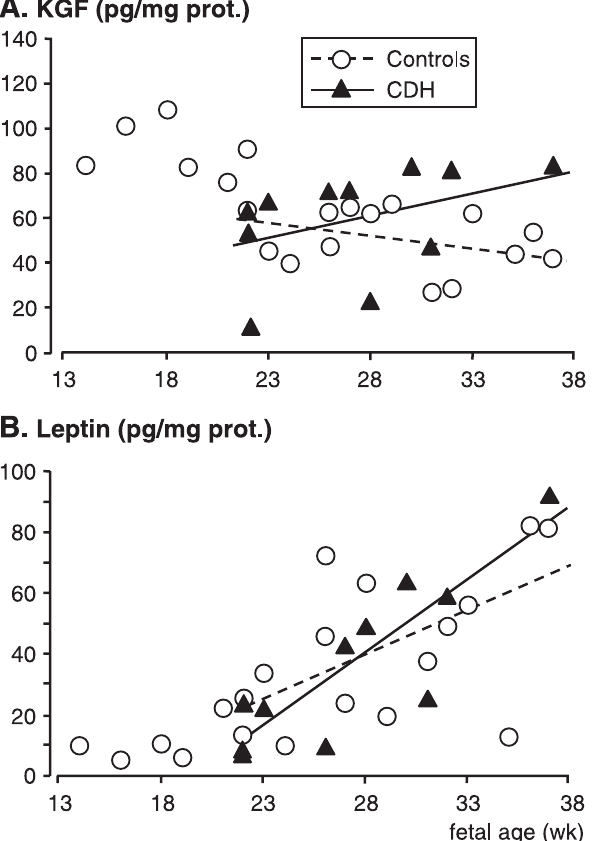
Figure 4. KGF and Leptin in Human Fetal Lungs ELISAs were performed on the lungs of 20 fetuses with nonpulmonary diseases used as controls, ranging from 14 to 37 wk of pregnancy, and on 11 fetuses with CDH ranging from 22 to 37 wk. Individual values are shown. Linear regression was performed for the period 22–37 wk when samples were available for both groups. KGF (A) displayed different profiles according to the groups concerned, with a negative slope for control lungs and a positive slope for CDH lungs ( (cid:2) 1.17 versus 2.23, respectively, p ¼ 0.03). Leptin assay (B) evidenced little change in control lungs before 22 wk; a similar linear increase occurred between 22 and 37 wk with no difference between groups (slope ¼ 4.82 versus 2.60 for controls and CHD samples, respectively, p ¼ 0.18).